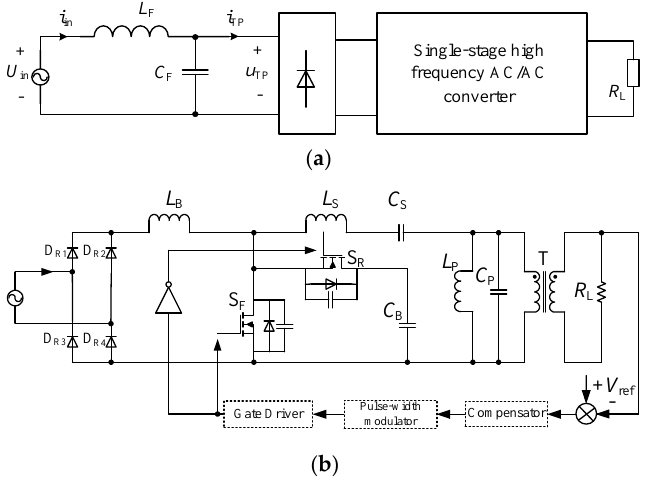
Figure 14. The input LC filter and the single − stage AC/AC converter with its control block diagram. ( a ) The input LC filter. ( b ) The single − stage AC/AC converter with its control block diagram.